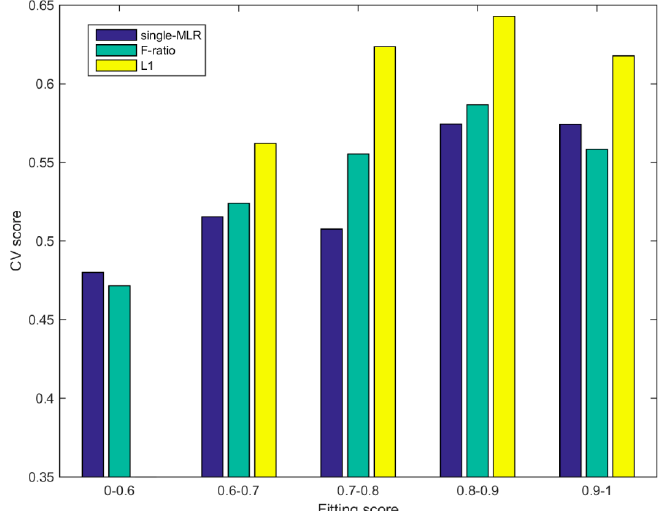
Figure 6. Histogram of the fitting scores with respect to CV scores (data refer to Figure 4) for three schemes, respectively.